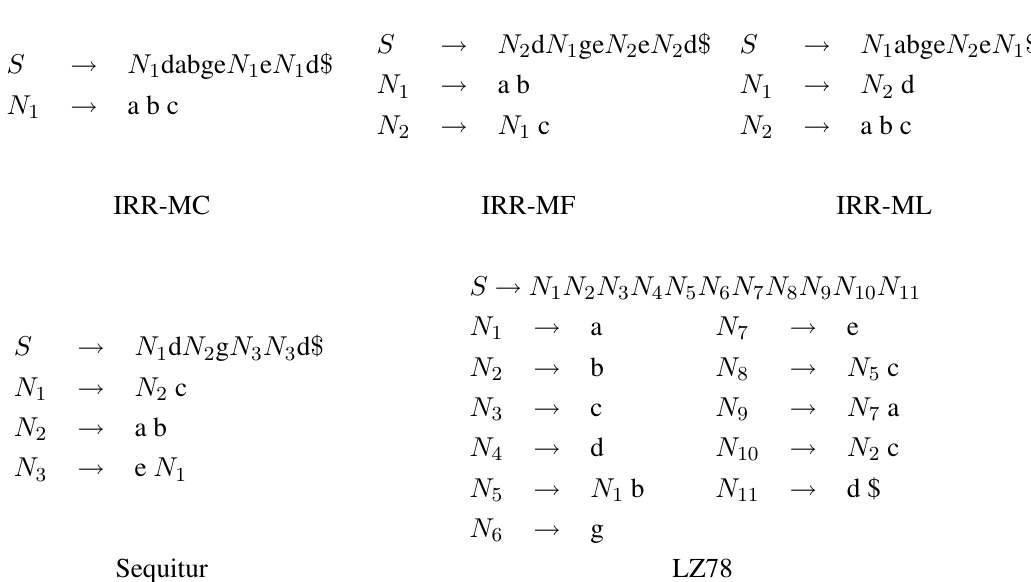
Figure 1. Grammars returned by classical algorithms on sequence abcdabgeabceabcd $